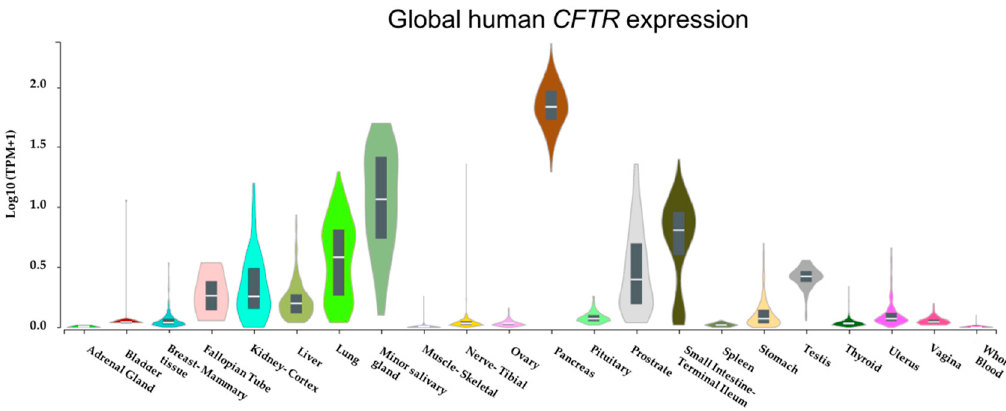
Figure 1. Cystic fibrosis transmembrane conductance regulator ( CFTR ) is abundantly expressed in many tissues. CFTR mRNA expression levels across several tissues were retrieved from Genotype-Tissue Expression (GTEx) Portal [5]. Expression values are shown in transcript per million (Log10) on the y -axis while x -axis represents tissues.